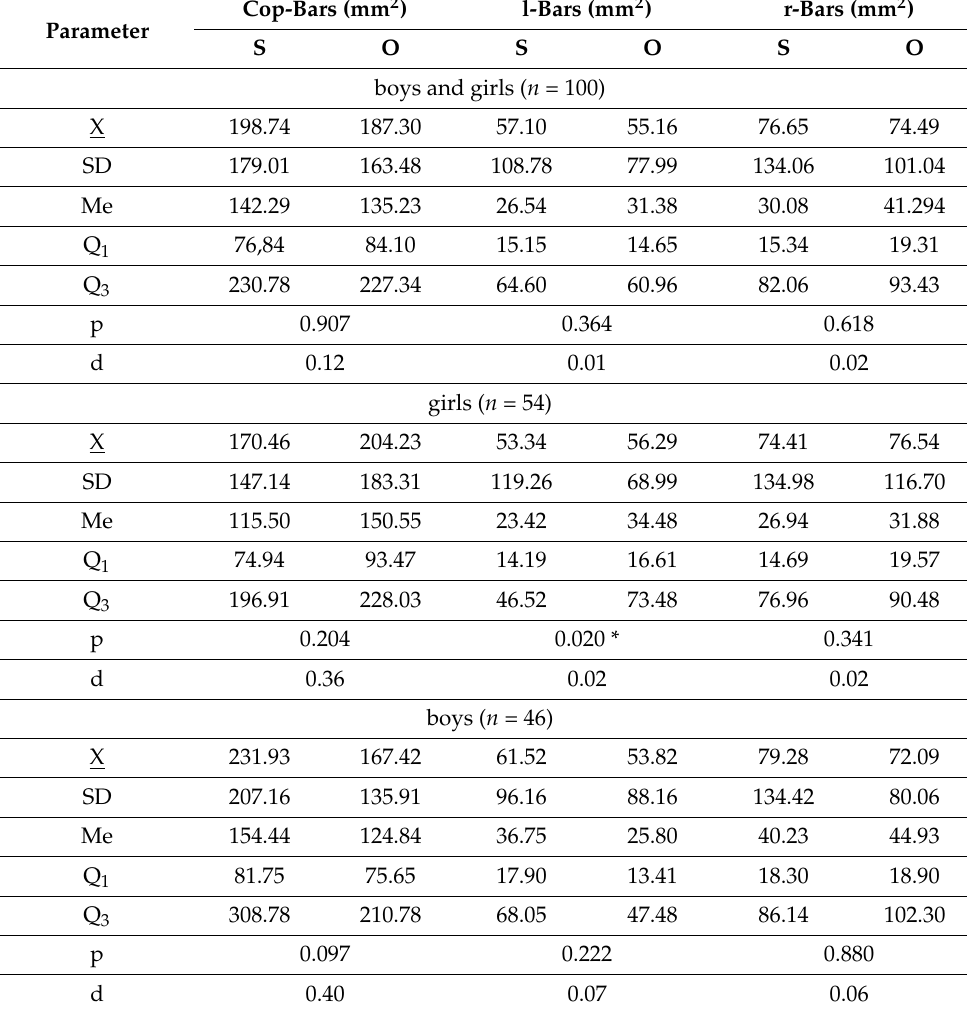
Table 2. Distribution of the results of the stabilographic tests at rest and after loading with a backpack in the study group and the statistical significance of differences measured with the Wilcoxon Matched Pairs